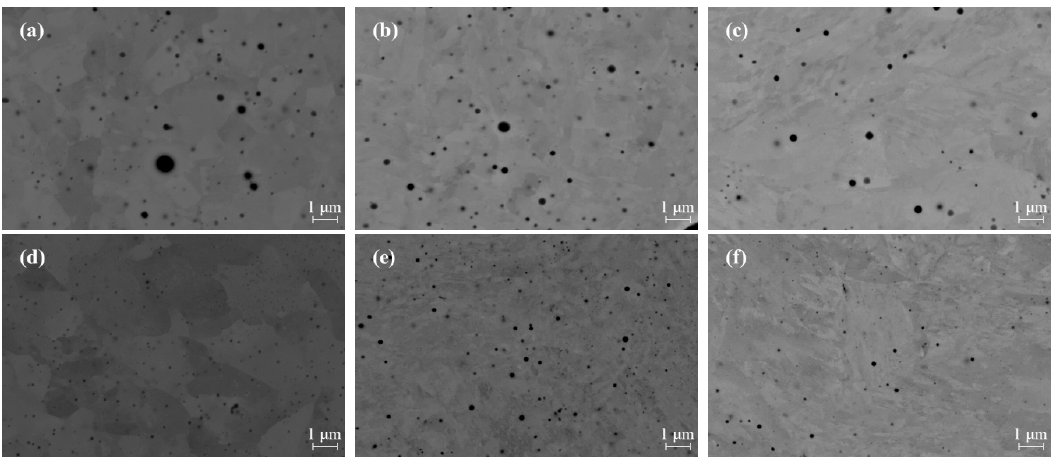
Figure 4. High-magnification FE-SEM micrographs of the nonmetallic inclusions in ( a ) W-1, ( b ) W-2, ( c ) W-3, ( d ) W-4, ( e ) WT-1 and ( f ) WT-2 steels.